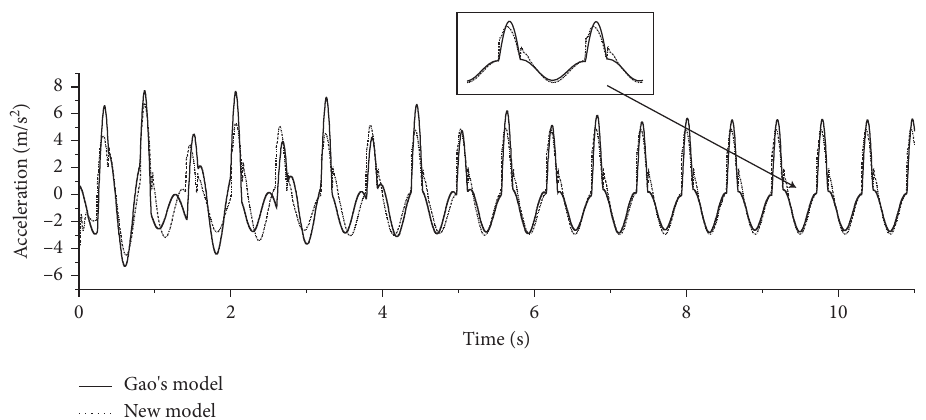
Figure 3: Acceleration of the COM in walking (initial vector not optimized).